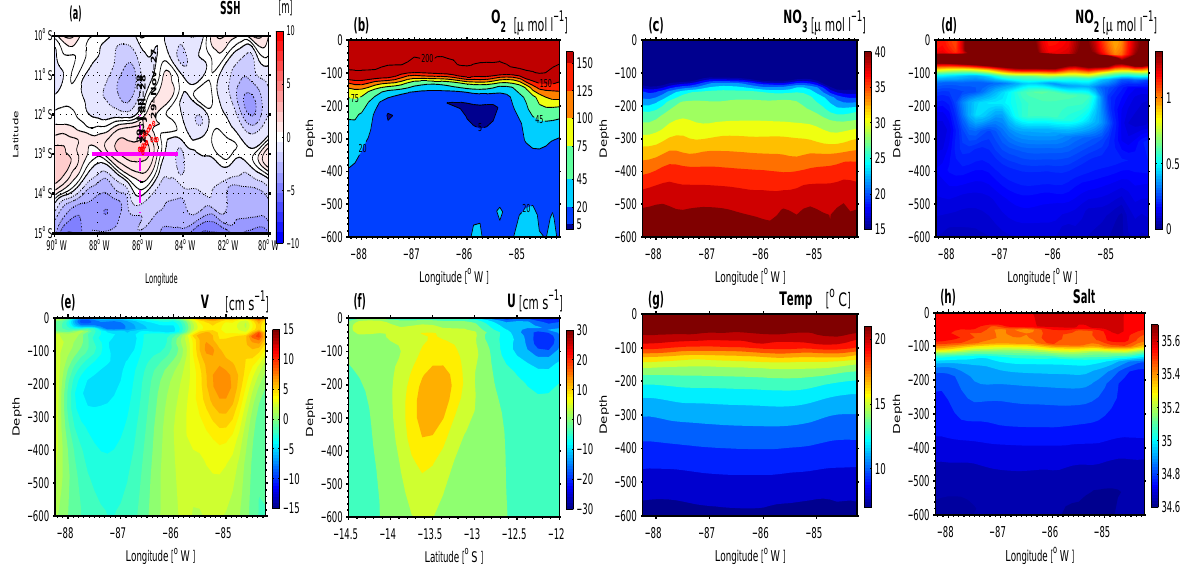
Figure 5. (a) Sea surface height (cm), (b) oxygen (µmolL − 1 ), (c) nitrate (µmolL − 1 ), (d) nitrite (µmolL − 1 ) concentrations, (e) meridional velocities (cms − 1 ), (f) zonal velocities (cms − 1 ), (g) temperature ( ◦ C) and (h) salinity across the eddy B sim centre. Nitrate, oxygen, nitrite, temperature, salinity and meridional velocity section around 13.2 ◦ S (magenta full line in a ). Section for zonal velocity around 85.8 ◦ W (magenta dashed line in a ). This dynamics corresponds to 27 January model year 28. The temporal evolution of the eddy is indicated by the red dots.